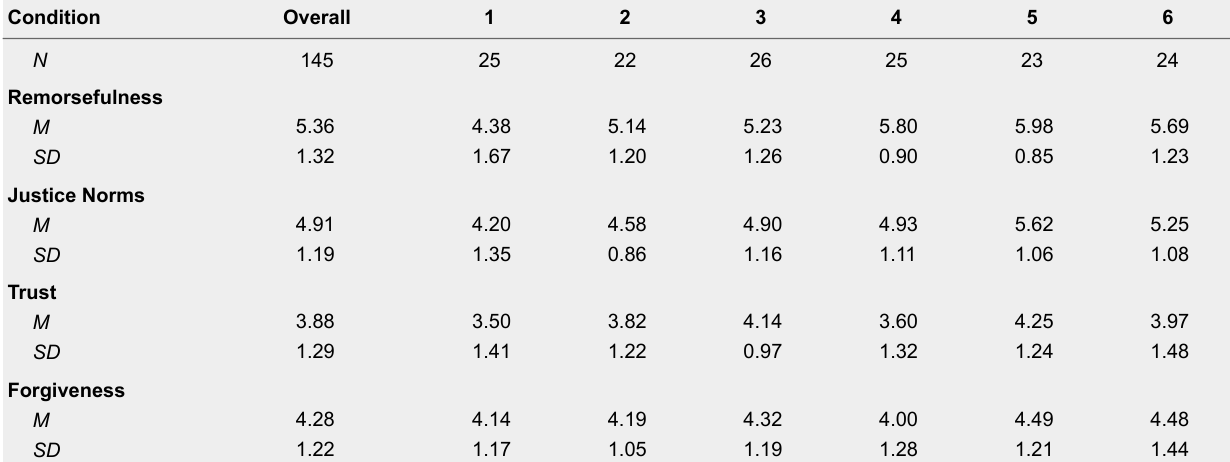
Descriptive Statistics